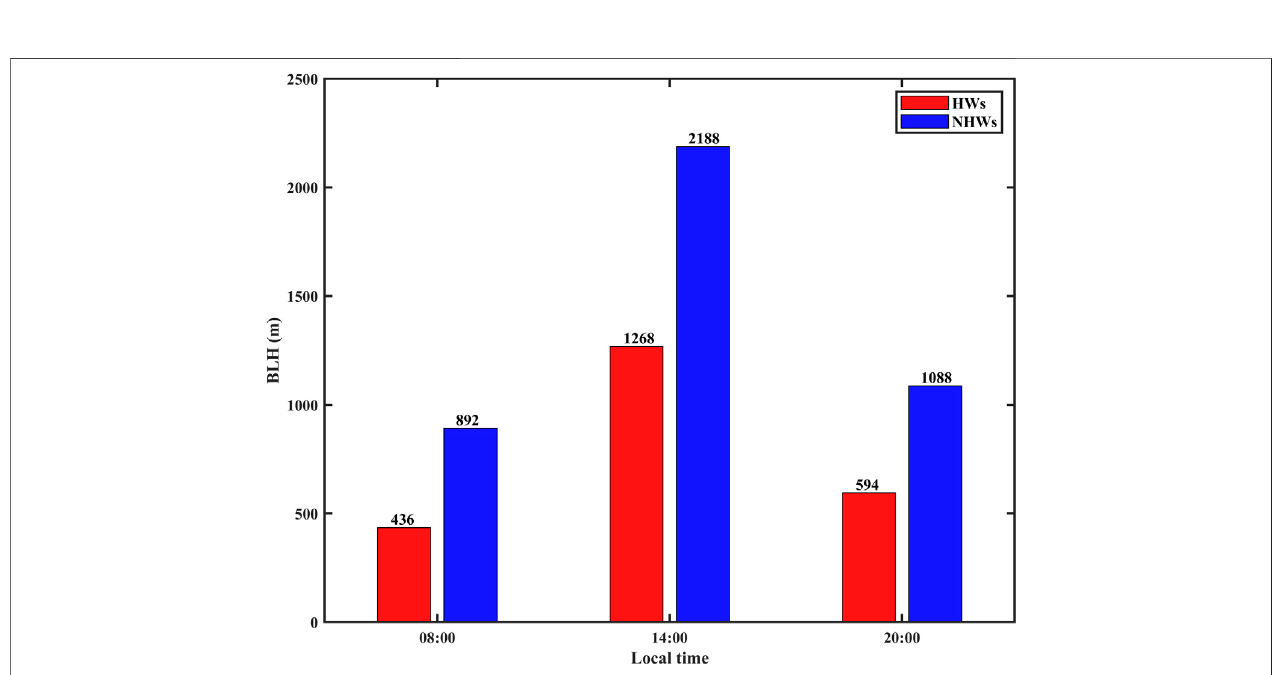
FIGURE 9 | The averaged BLH during a case for 2016.07.06 – 2016.07.11, included both HW days (2016.07.06 – 2016.07.08) and NHW days (2016.07.09 – 2016.07.11).